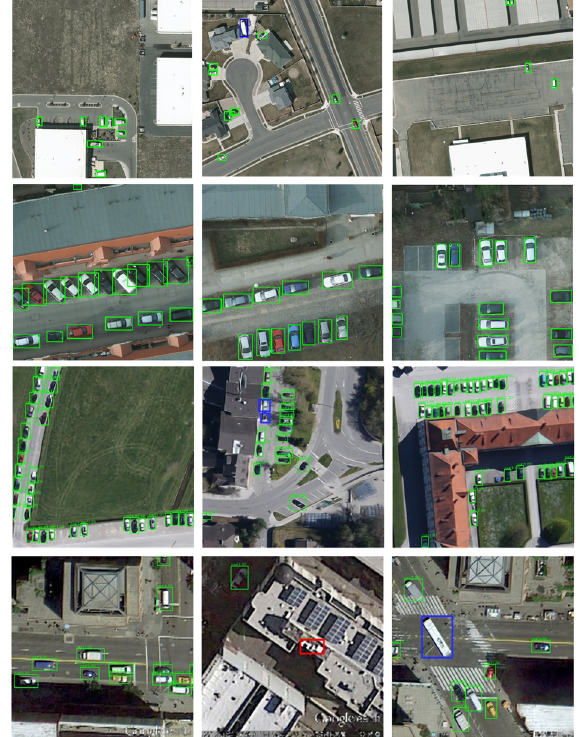
Figure 7. Examples of the remote sensing images from VEDAI Munich (1st row), Potsdam (2nd row), DLR (3rd row), UCAS-AOD (4th row) datasets respectively. The vehicle detection results of our method are marked with green boxes. Blue and red boxes indicate missing and false alarm